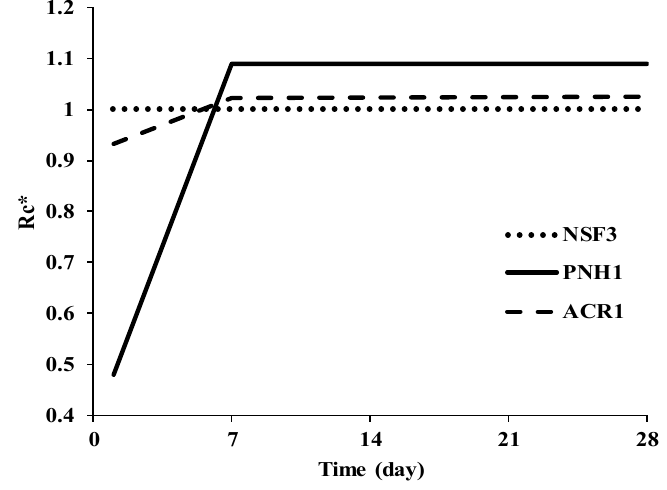
Figure 7. Mean values of compressive strength (Rc* = R C /R C,NSF ).